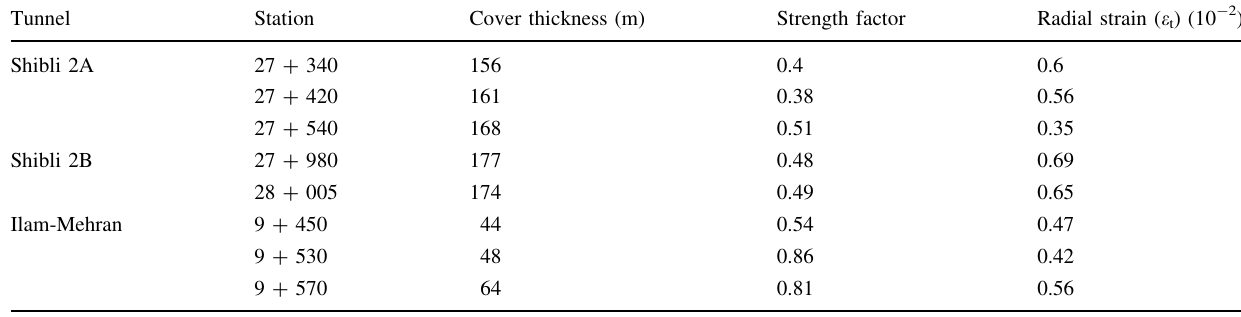
Table 5 Tunnel radial strain and strength factor Tunnel Station Cover thickness (m) Strength factor